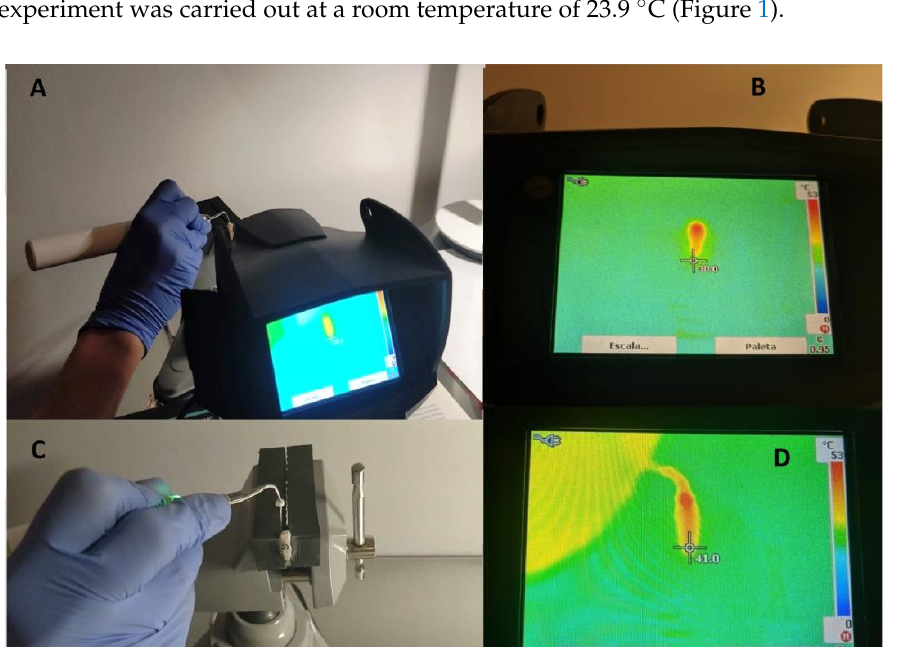
Figure 1. Experimental set up. ( A , C ) Positioning of the tooth with respect to the camera and location of the vice. ( B , D ) Images of the thermographic camera.